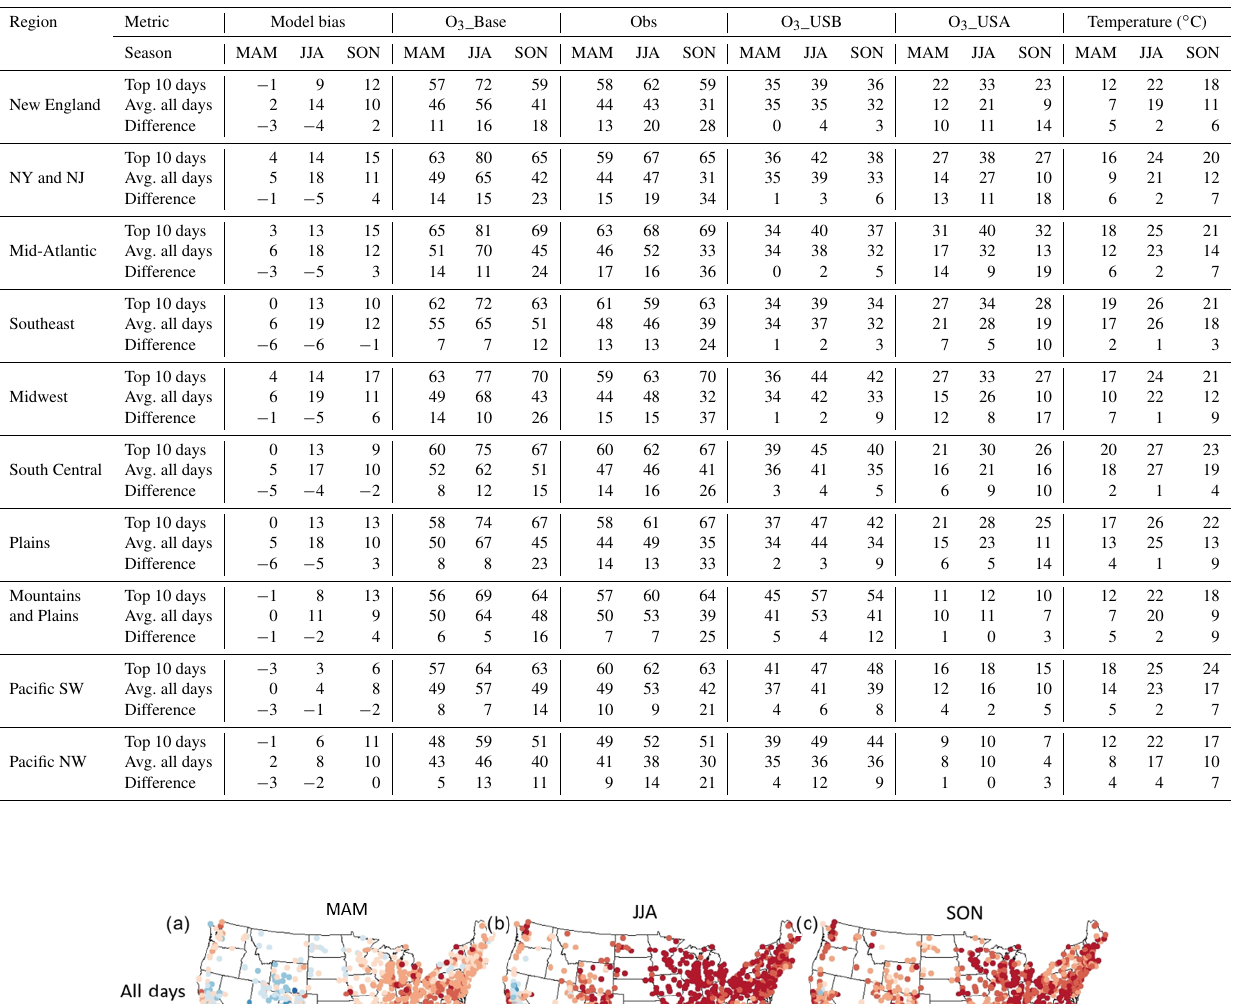
Table 2. Summary information for each region. Columns show the model bias and O 3 abundances in the O 3 _Base, O 3 _USB, and O 3 _USA simulations, and in the observations as well as for daily average temperature (1) on the O 3 _top10obs days in each season (average of 2004– 2012), (2) across all days in each season (average of 2004–2012), and (3) the difference between these values, rounded to the nearest whole number.